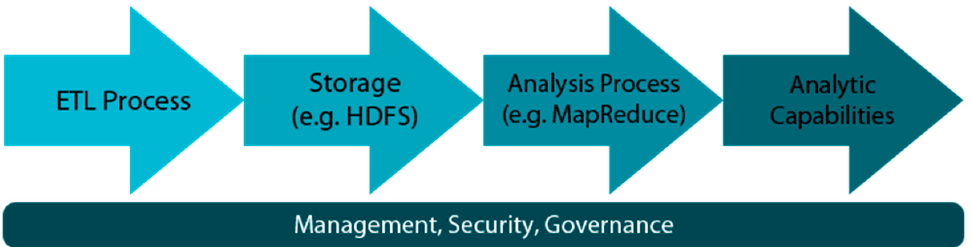
Figure 2. Typical Big Data architecture, based on [18].